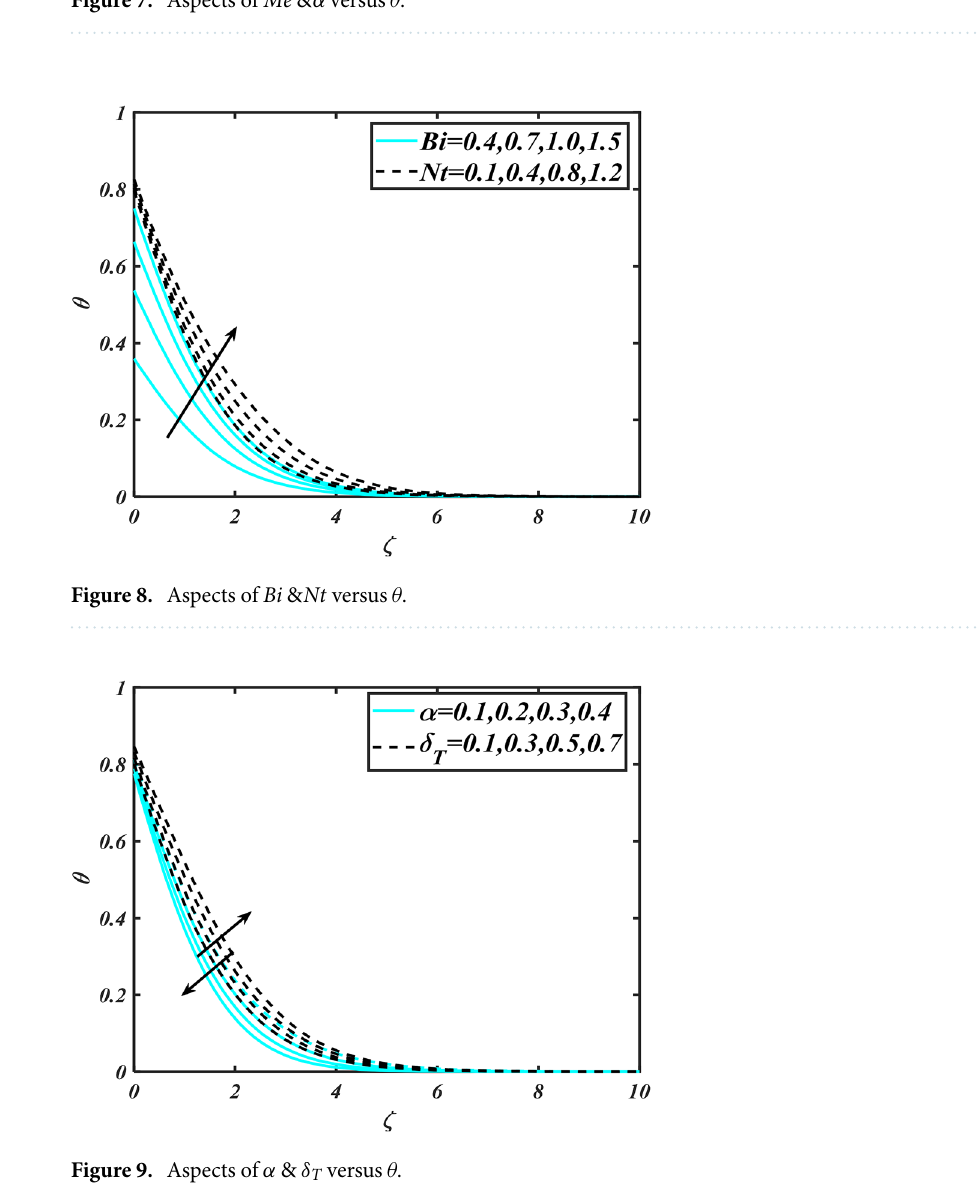
Figure 7. Aspects of Me & α versus θ .